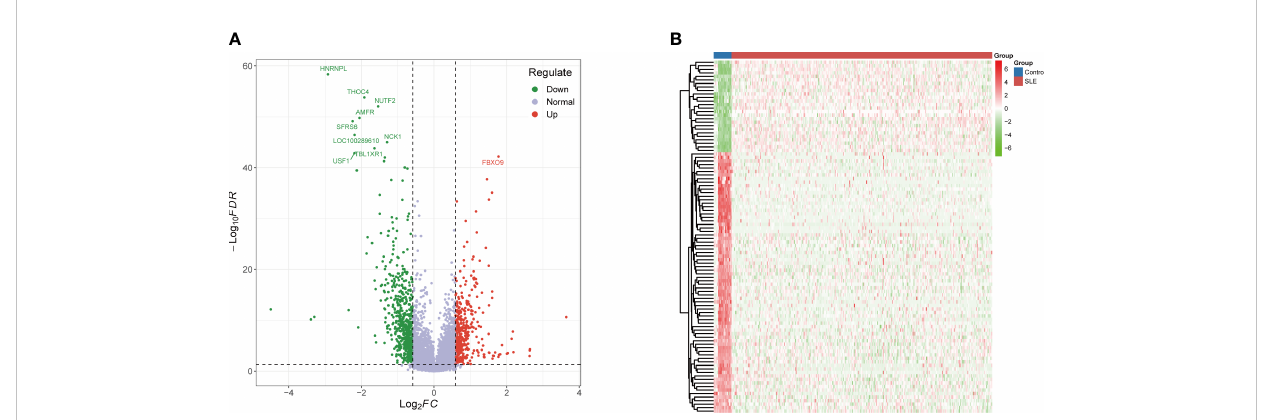
FIGURE 2 Identi fi cation of DEGs. (A) Volcano plot: The volcano plot was constructed using the fold change values >1.5 and adjusted P-values < 0.05. (B) The heatmap of the DEGs and different colors represent the trend of gene expression in different PBMCs. The top 100 genes ranked according to adjusted p-values as shown in this fi gure. DEGs differentially expressed